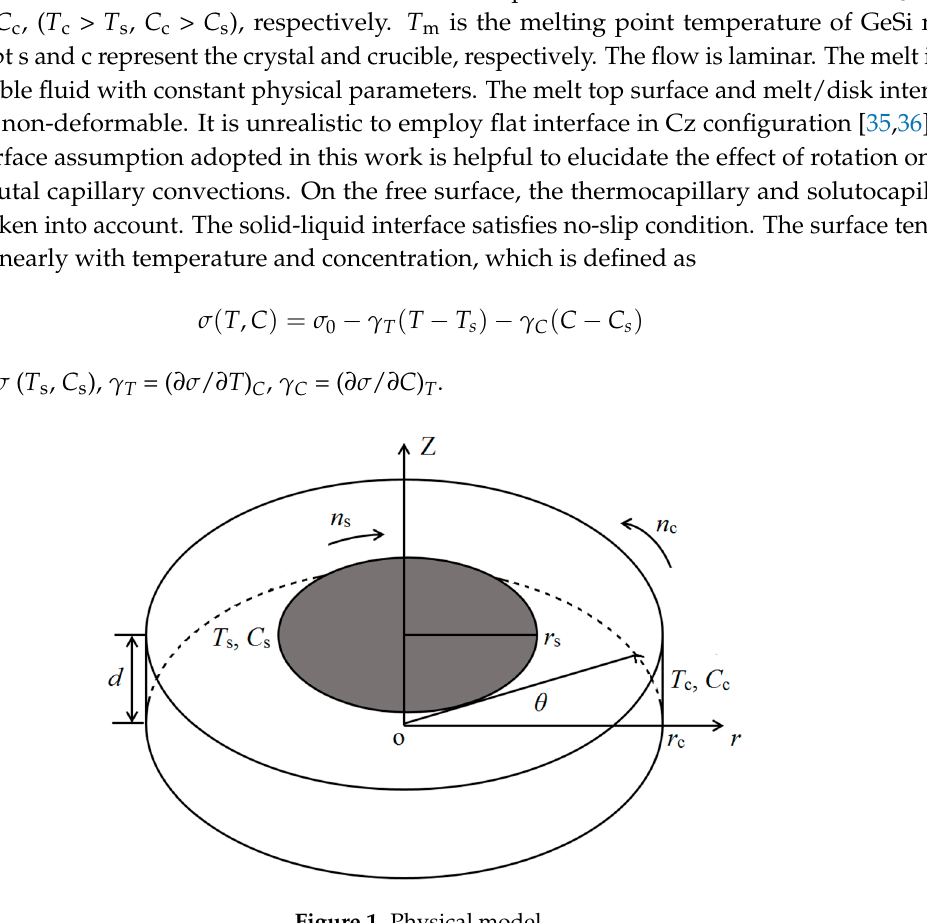
Figure 1. Physical